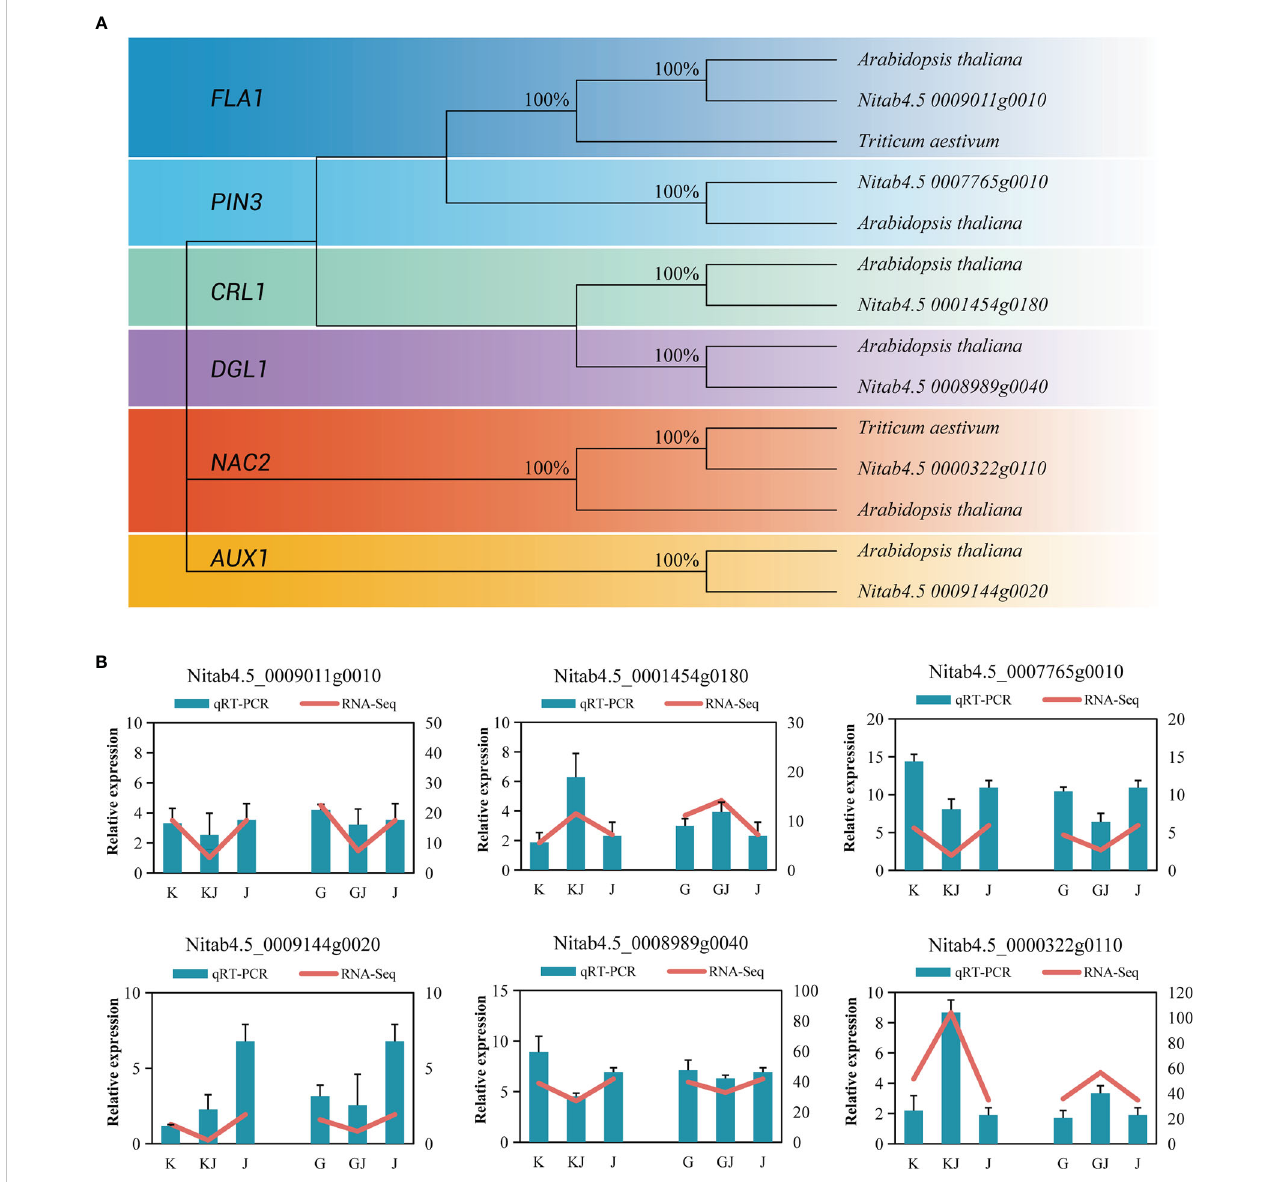
FIGURE 9 (A) Phylogenetic trees of root development genes in tobacco. (B) Comparison of RNA-seq and RT-qPCR gene expression levels of root related genes in two hybrids and their